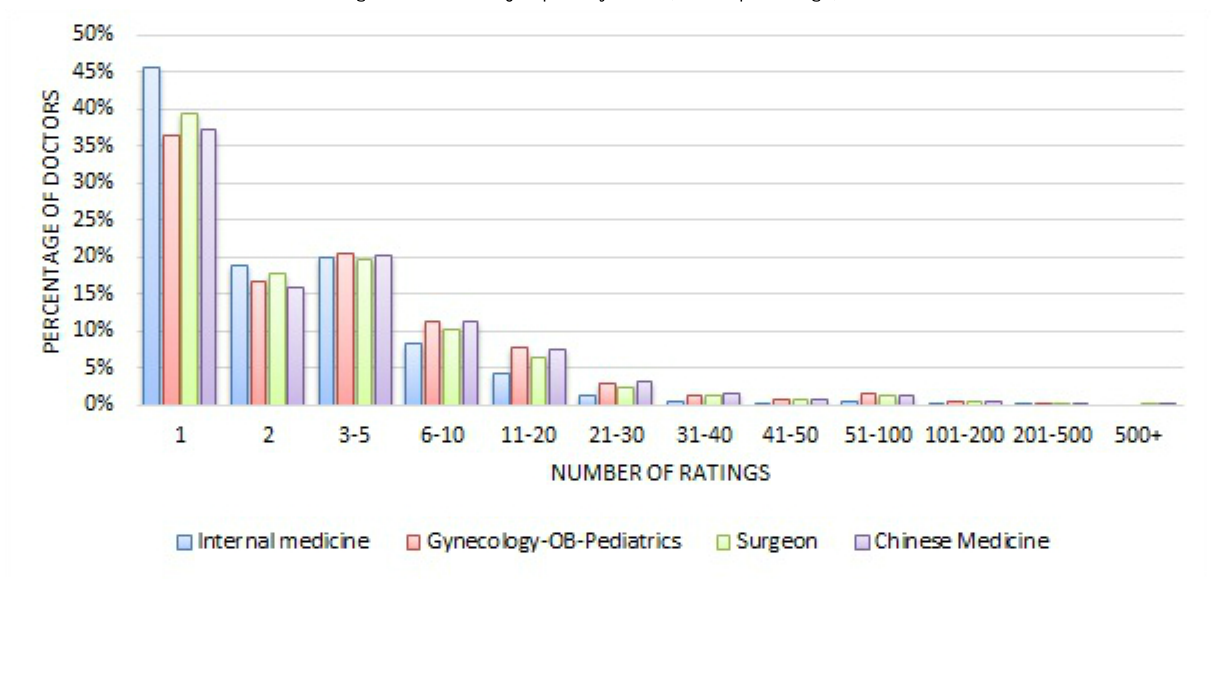
Figure 2. Distribution of the number of ratings across four major specialty areas (relative